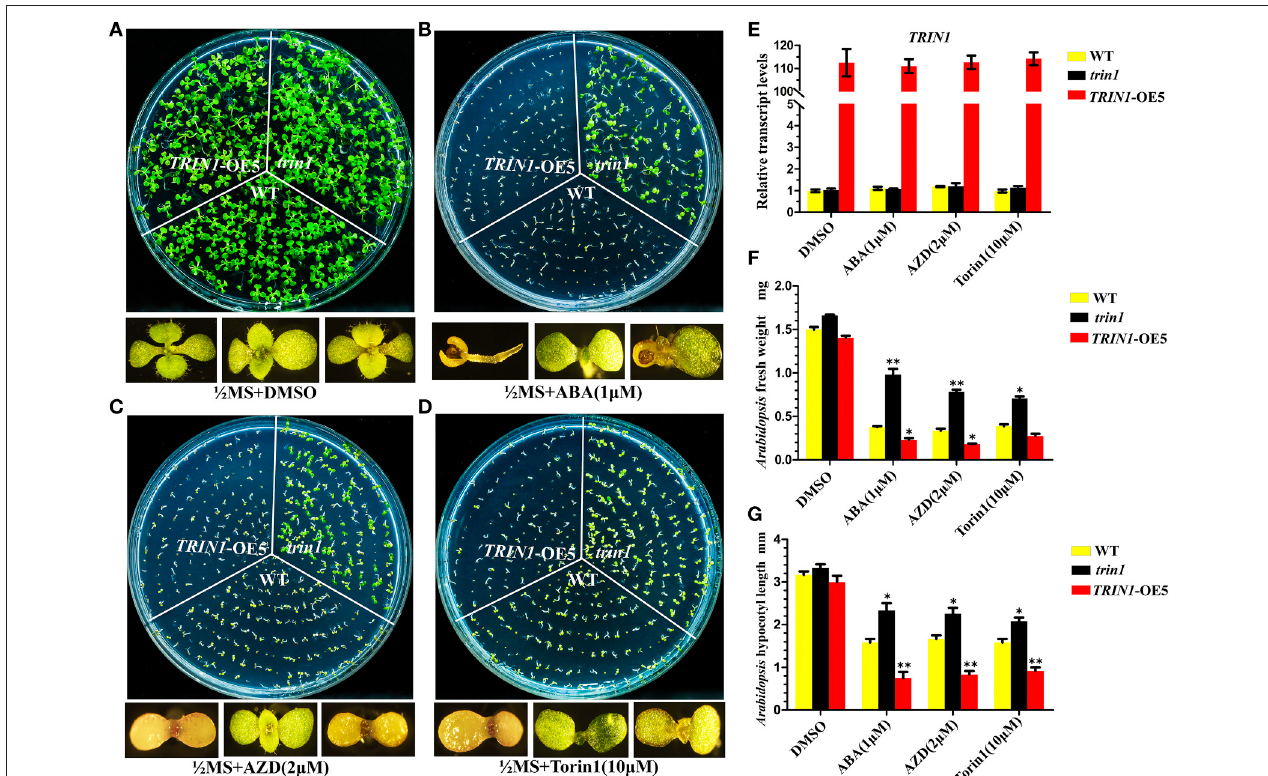
FIGURE 3 | Seeds of trin1 , TRIN1 -OE5, and WT were treated with ABA and mTOR kinase inhibitors. (A – D) trin1 , TRIN1 -OE5, and WT seeds were cultured on different medium for 10 days; Enlarged pictures of TRIN1 -OE5, trin1 , and WT plants from left to right in the bottom. AZD, ABA, and Torin1 were dissolved in DMSO. (A) Using ½ MS containing 1 µ g/mL DMSO as controls. (B–D) trin1 plants are insensitive to ABA, AZD and Torin1, whereas TRIN1 -OE5 plants are sensitive. (E) qRT-PCR analysis of ABI4 transcripts from 10-day-old WT, trin1, and TRIN1 -OE5 plants treated with DMSO, AZD (5 µ M), and Torin1 (10 µ M) for 36h. The data represent the mean ± SE of n = 3 independent experiments. (F) Arabidopsis fresh weight of trin1 , TRIN1 -OE5, and WT plants treated as described in (A–D) . The data represent the mean ± SE of n = 3 independent experiments each containing 30 plants per treatment. Asterisks denote Student’s t- test significant difference compared with WT plants ( * P < 0.05 ; ** P < 0.01 ). (G) Arabidopsis shoots length of trin1 , TRIN1 -OE5, and WT plants treated as described in (A–D) . The length from aboveground to rosette was measured. The data represents an average of 30 seedlings with three duplicates. Error bars indicate ± SD for triplicates. Asterisks denote Student’s t- test significant difference compared with WT plants ( * P < 0.05 ; ** P < 0.01 ).